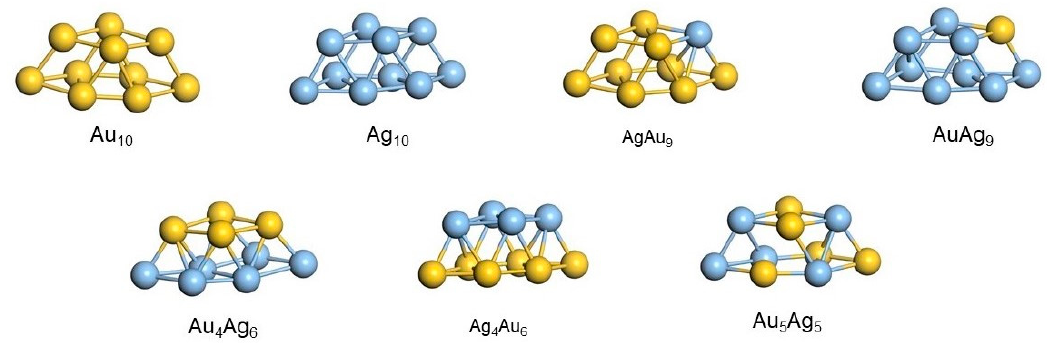
Figure 7. Optimized structures of mono ‐ and bimetallic Au x Ag y (x + y = 10) clusters. The adsorption of octanol on Au x Ag yq clusters (x + y = 10, with a charge of q = 0 or +1) was simulated through adsorption (1) and (2); the study involved determination of the structure (Figure 8) and energy of C 8 H 17 OH_Au x Ag yq complexes.